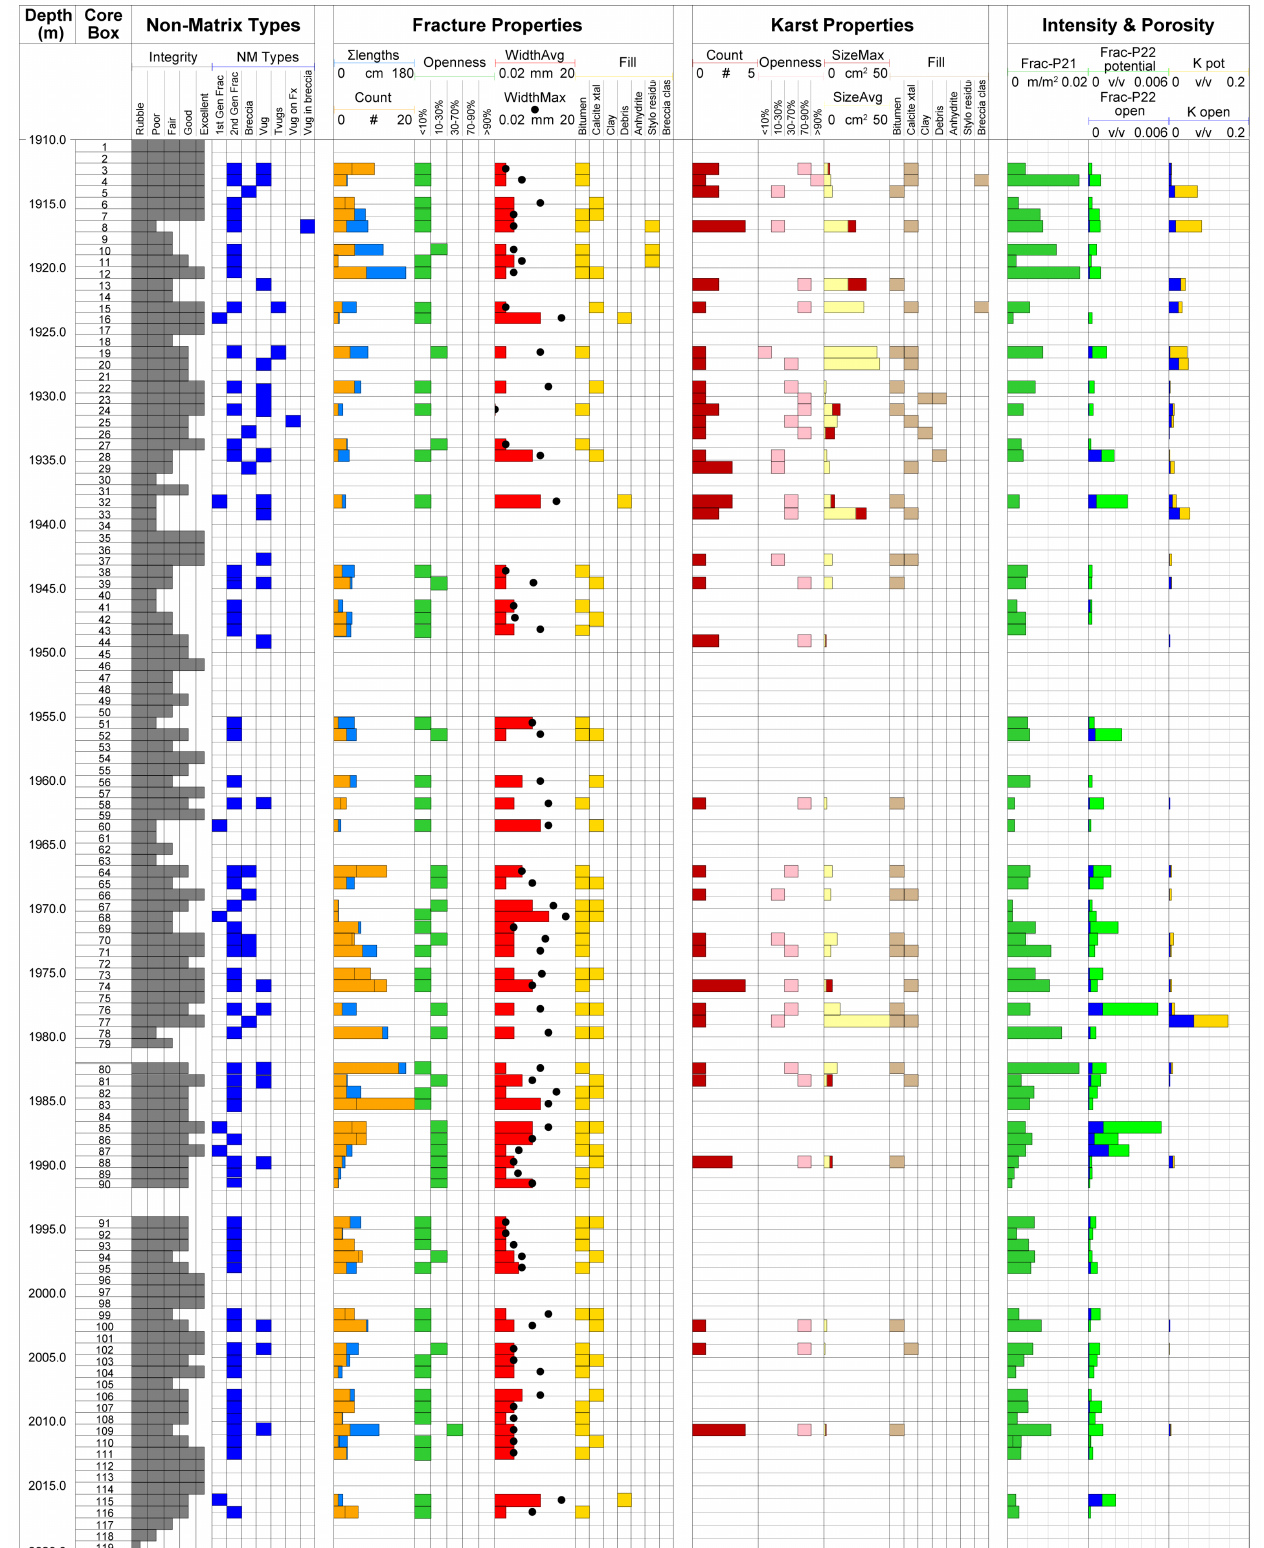
Figure 4. Single well showing the vertical distribution of non-matrix observations obtained with the NMQP